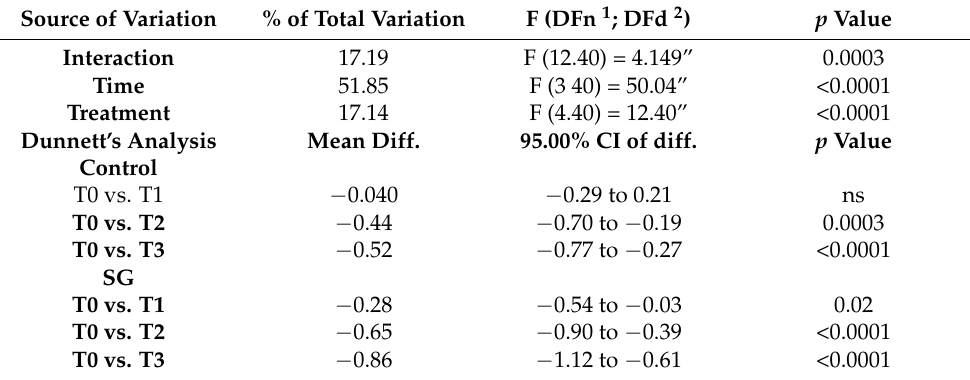
Table 1. Summary of the two-way ANOVA comparison and Dunnett’s multiple comparison test considering the time